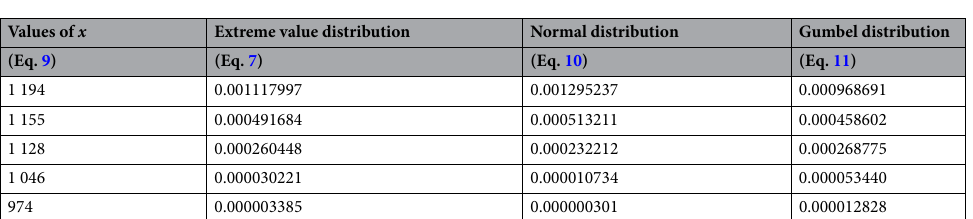
Table 1. Extreme value distribution approximated by a Normal distribution and a Gumbel distribution for selected fractile values and for n = 25 fibre strands. The values of x correspond to the 5%, 2%, 1%, 0.1%, and 0.01% values of the original extreme value distribution.